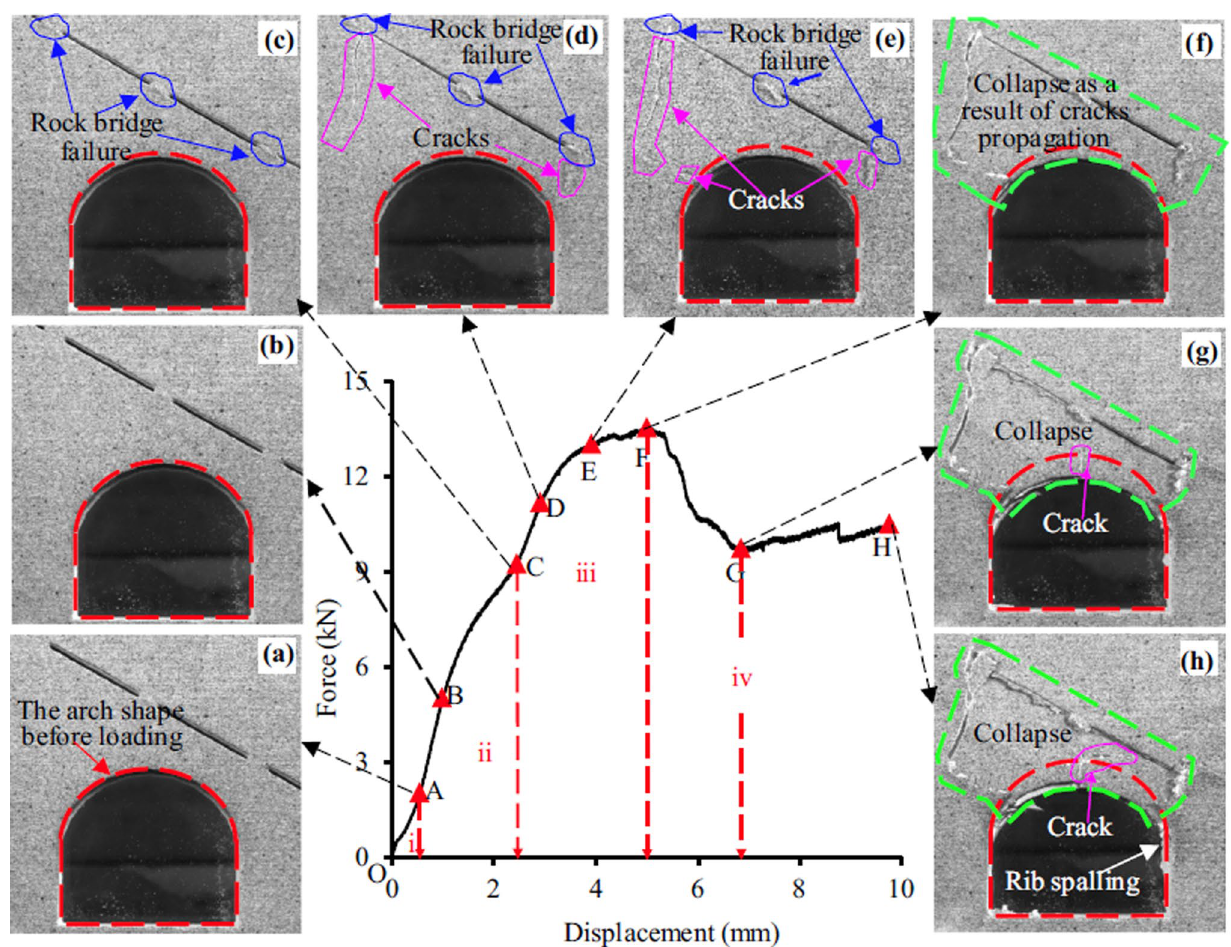
Fig. 14 Typical test curve and macroscopic failure evolution process of the single-fault tunnel model (Song et al.